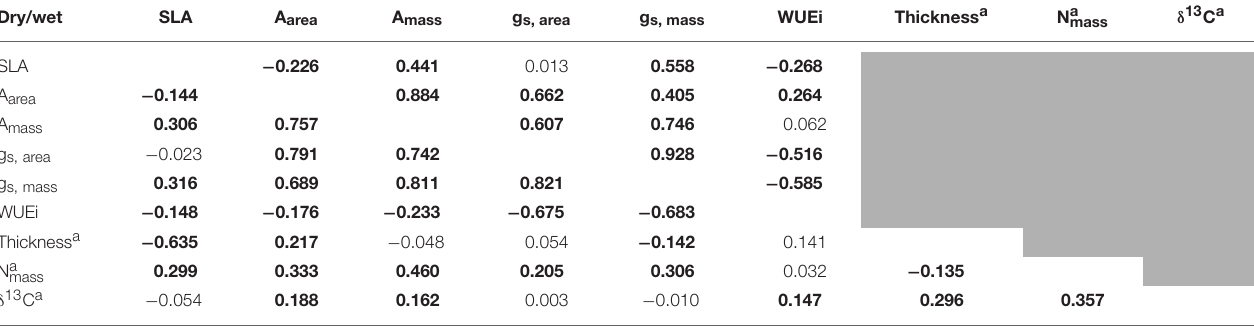
TABLE 5 | Pearson correlations among traits in dry (below diagonal) and wet (above diagonal) seasons. Dry/wet SLA A area A mass g s, area g s, mass Thickness a SLA − 0.226 0.441